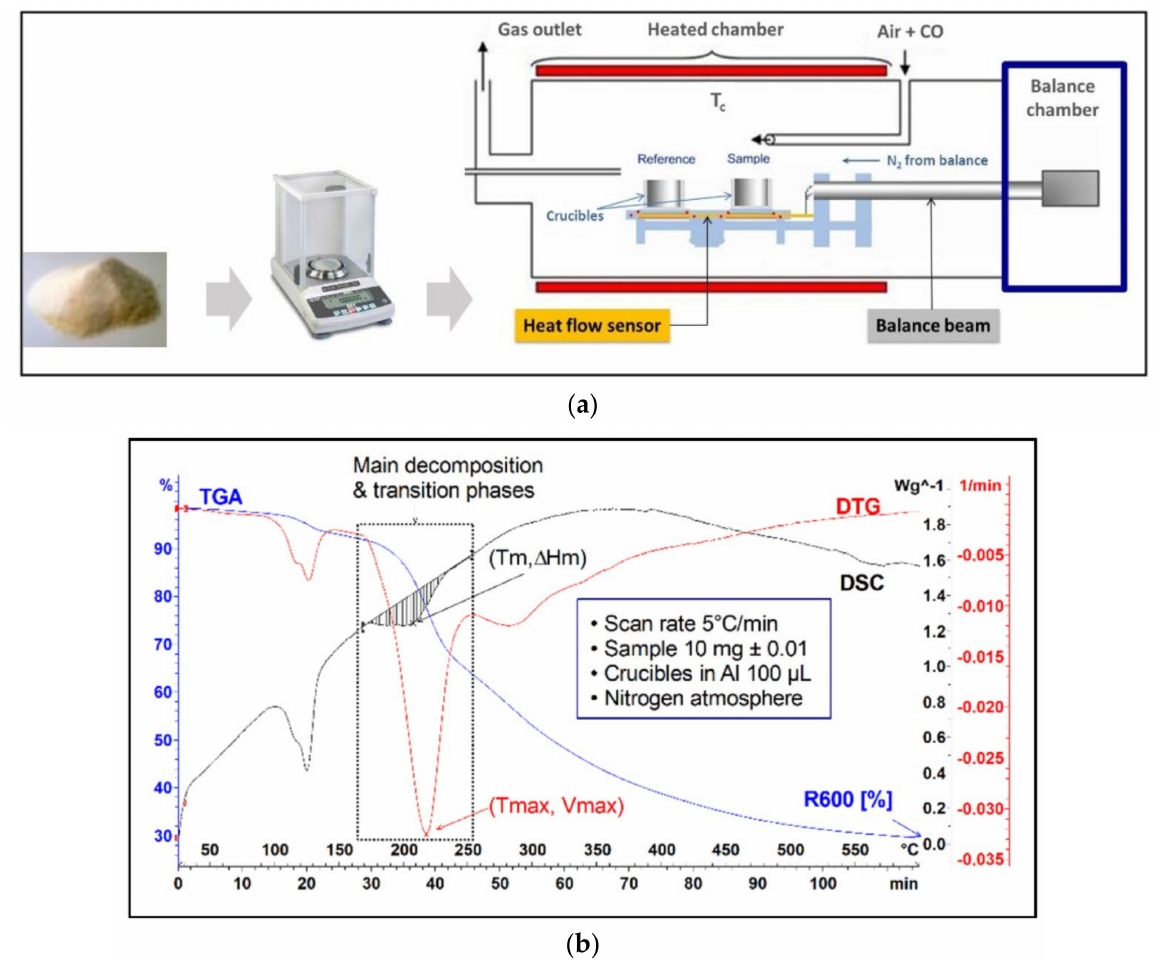
Figure 1. Main steps of the thermal probiotic powder profiling and fingerprinting experimentation: ( a ) from powder weighing to TDA-DSC analysis, and ( b ) output